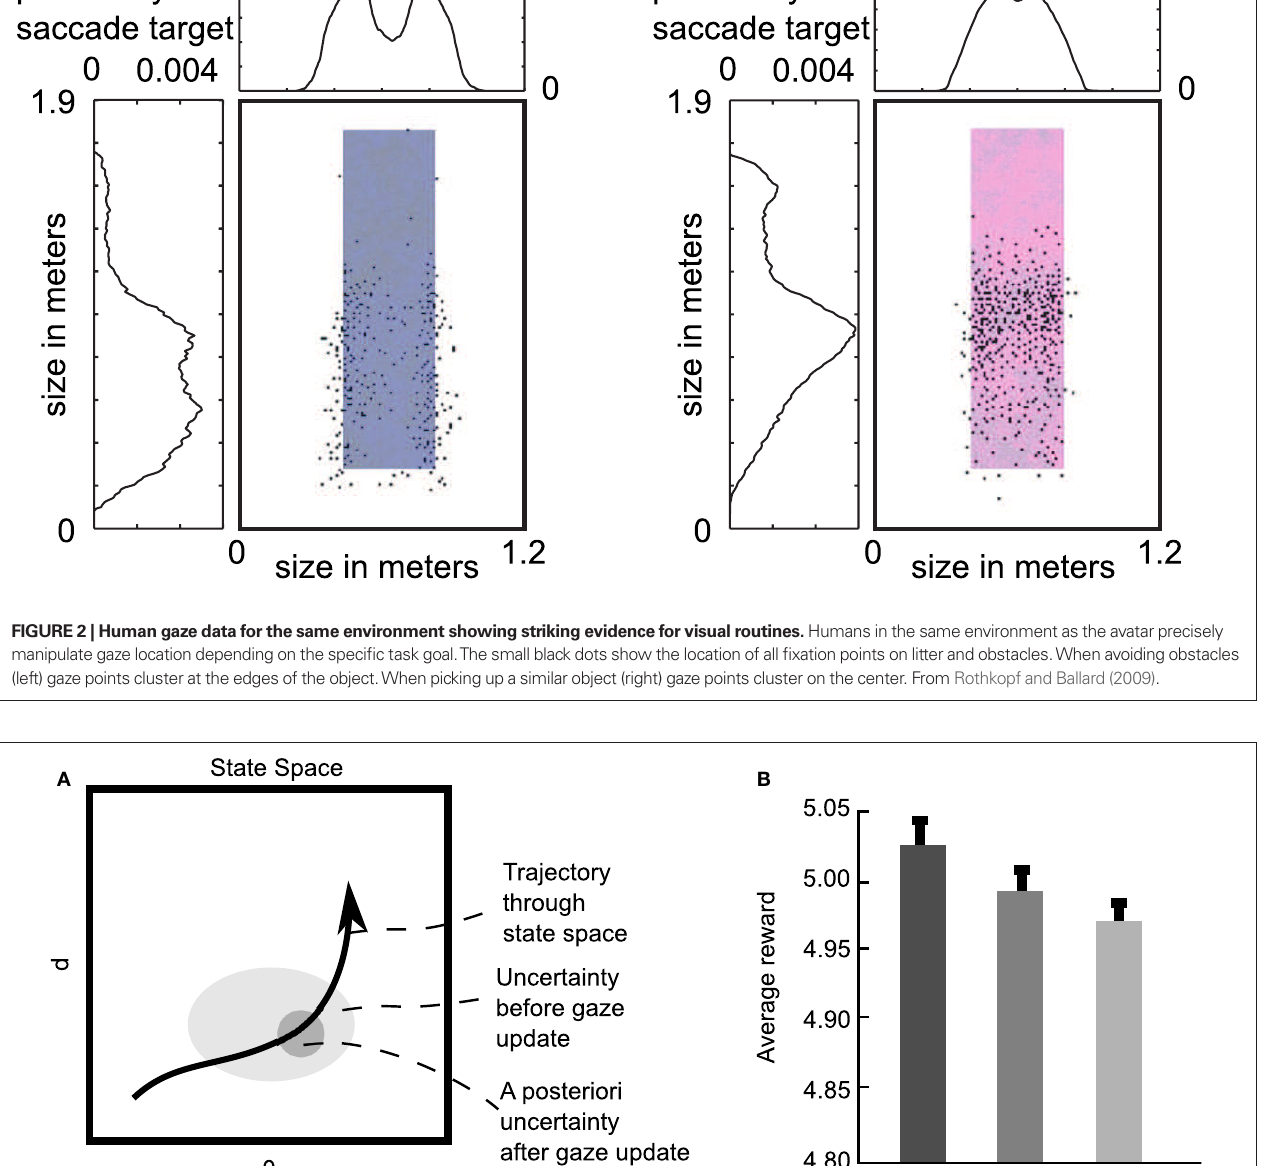
area). If the behavior succeeds in obtaining a fixation, state space uncertainty is reduced (smaller shaded area). The reinforcement learning model allows the value of reducing uncertainty to be calculated. (B) The Sprague model out performs other models. Bars, left to right: Sprague model (1), round-robin (2), random selection (3).